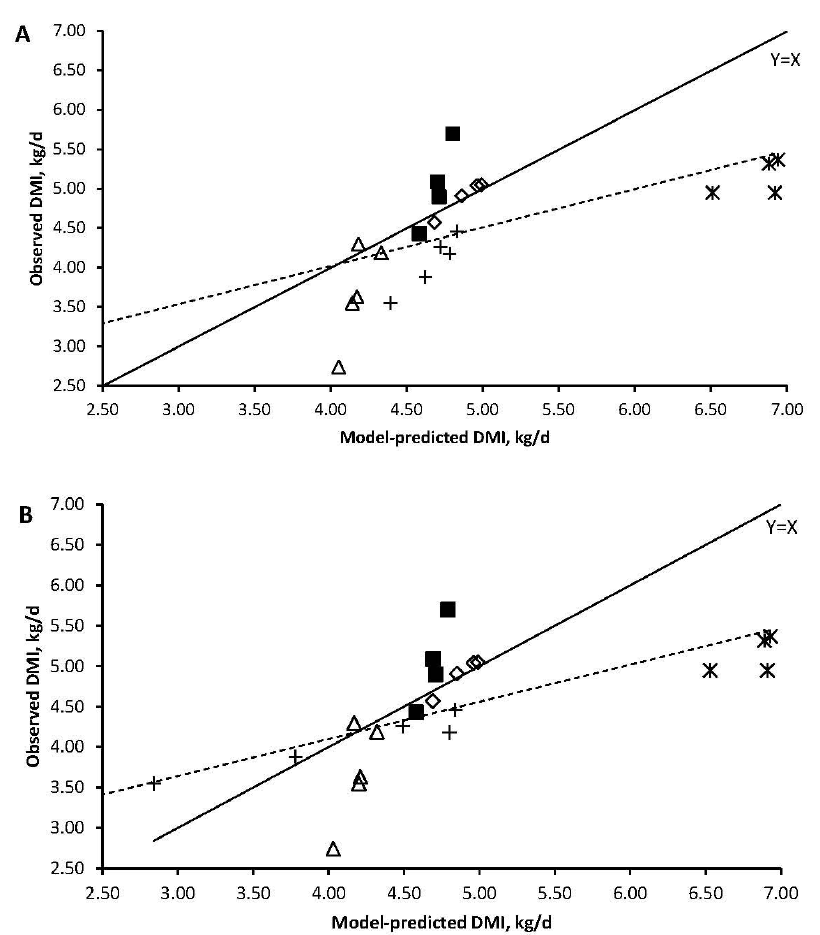
Figure 1. Relationships between observed and model-predicted dry matter intake (DMI) using level 1 (A) or level 2 (B) solutions of the Large Ruminant Nutrition System. Symbols are studies 1 (  ), 2 (■), 3 (  ), 4 (+), and 5 (  ). Solid line is the Y = X and the dotted line is the linear